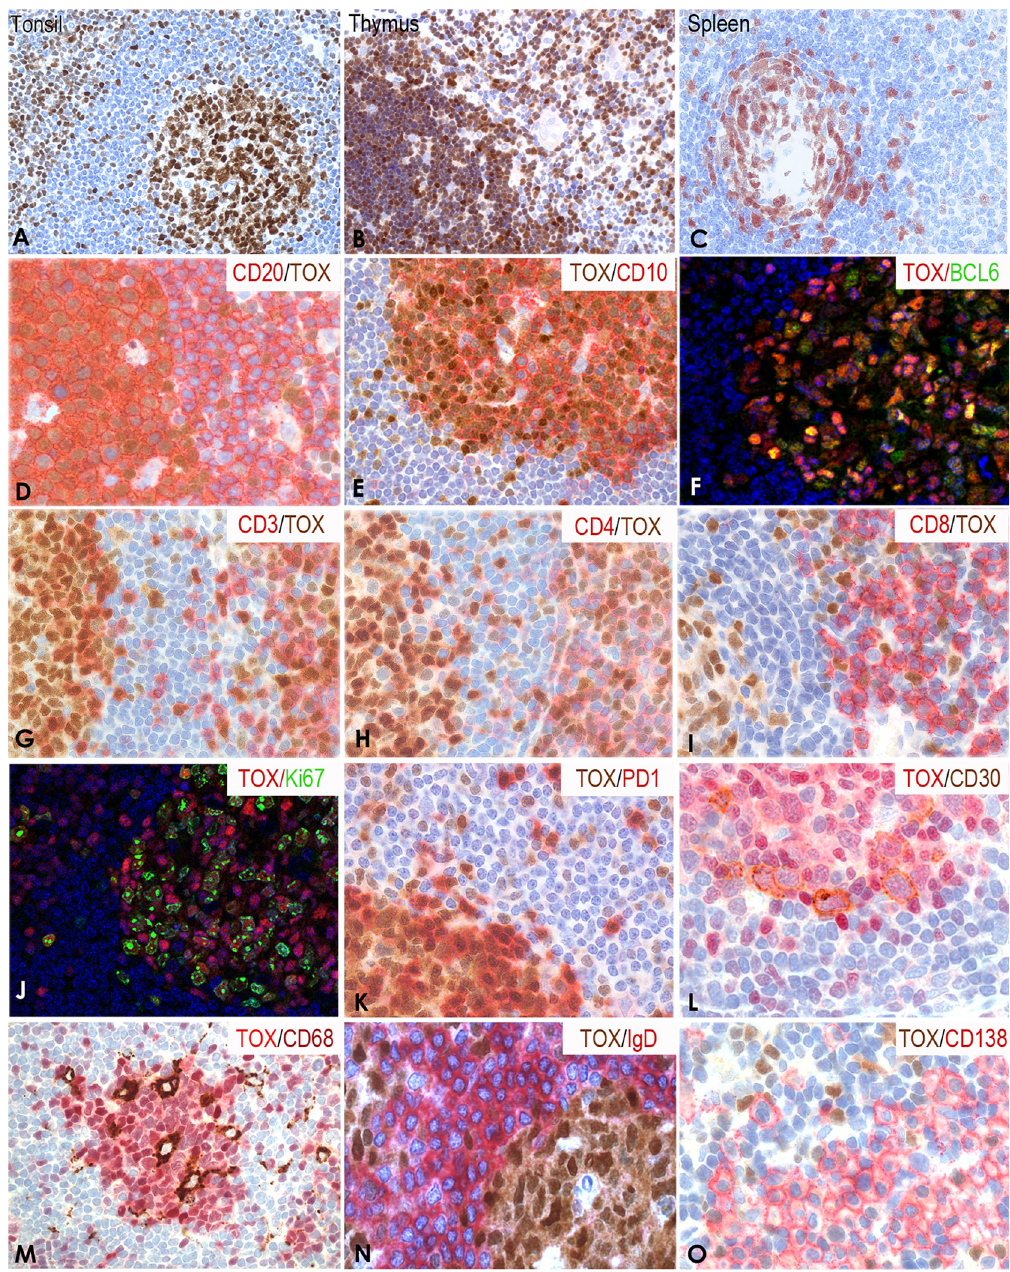
Fig 4. Expression of TOX in normal lymphoid tissues. (A) Single immunoperoxidase labeling in tonsil showed strong nuclear staining of TOX in GC B and T cells and in T cells in the interfollicular area. (B) TOX was also highly expressed by CD4/CD8 double positive T cells in thymus cortex and in proportion of mature B and T cells in the medulla. (C) In spleen, TOX was expressed by B and T cells in the white pulp GC and in scattered cells in the red pulp. Double immunenzymatic staining showed high expression of TOX [25] in CD20+/CD10+ cells (red) (D and E) in the GC and also in a proportion of B cells in the T-cell area. (F) Double immunofluorescence staining showed that the large majority of BCL6+ cells (green) also expressed TOX (red). High numbers of CD3+ T lymphocytes (red) (G) were TOX+ [25], the majority of them being CD4+ (red) (H) and only 5–10% were CD8+ (red) (I). Double immunofluorescence staining showed that a high number of Ki67 positive cells (green) co-expressed TOX (red) (J). All the PD1+ TFH (red) (K) and CD30+ activated B cells (L) [25] were TOX + (brown and red respectively). CD68 positive macrophages (M) [25], IgD + lymphocytes (red) (N) and CD138+ plasma cells (red) (O) lacked TOX